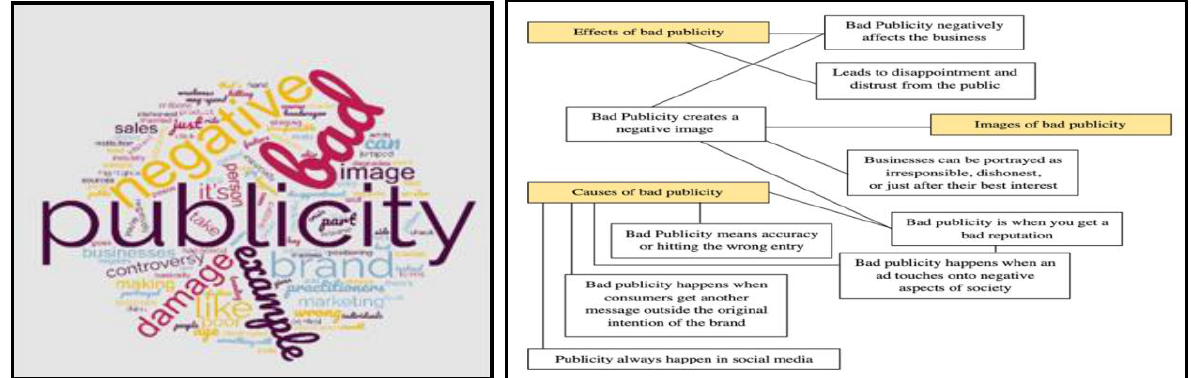
Figure 13: Definition of Bad Publicity Figure 14: Thematic Map of Bad